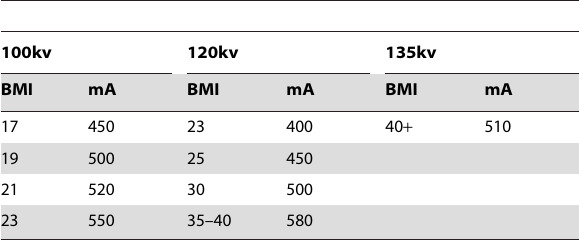
Table 2. Tube voltage/tube current adjustment table based on